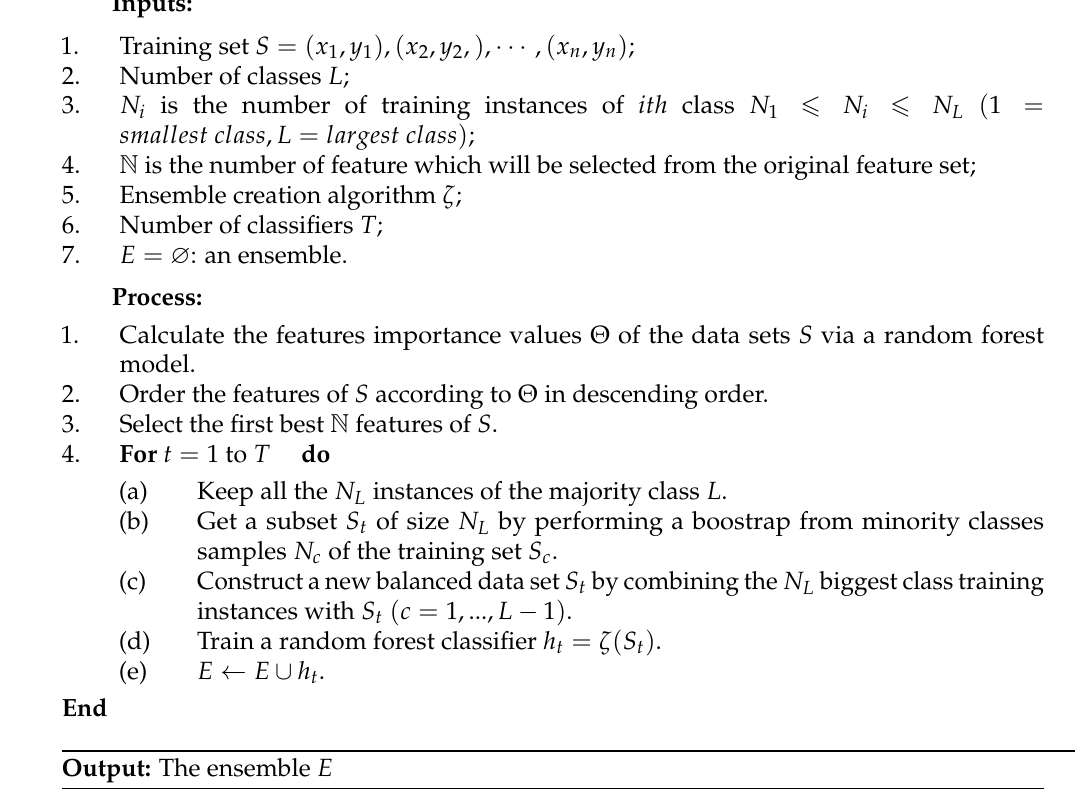
Algorithm 3 Oversampling-based double random forest